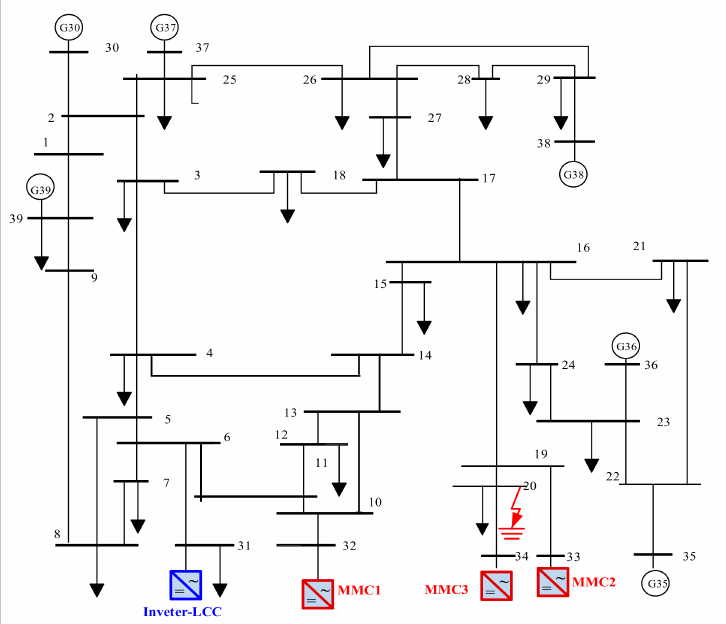
Figure 9. Modified New England 39-bus